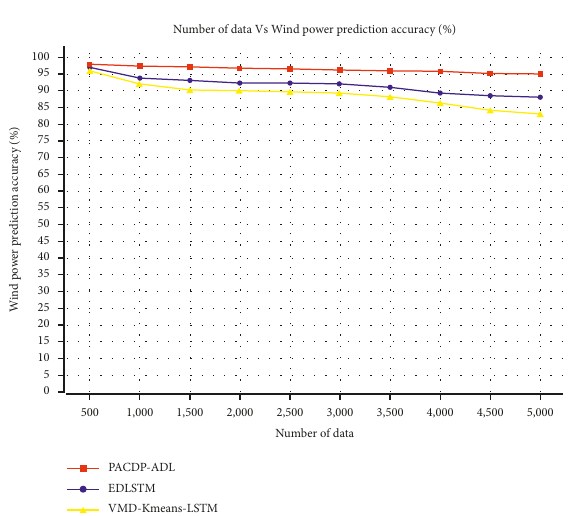
Figure 4: Graphical representation of wind power prediction